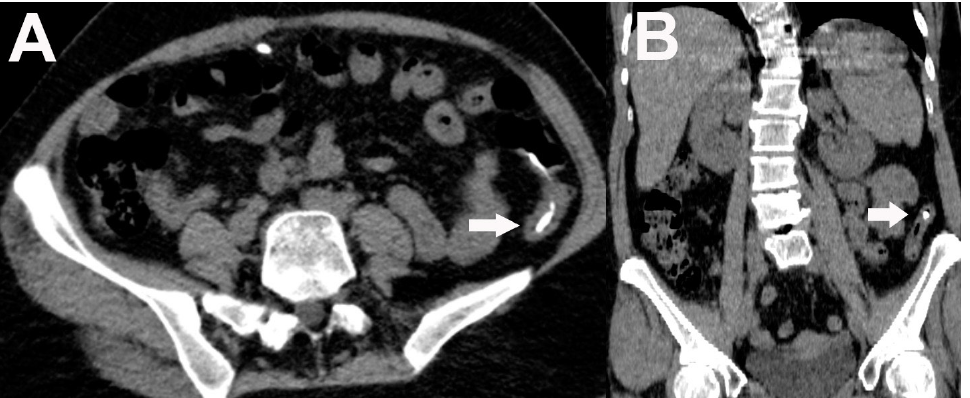
Figure 1: Native abdominal computed tomography scan indicates bowel perforation. Axial (A) and coronal (B) views. White arrow indicates the distal end of the ventriculoperitoneal shunt catheter inside the colon descendens.